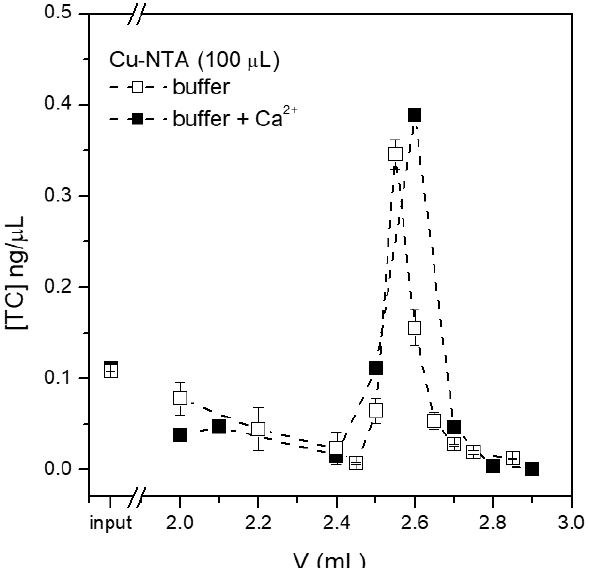
Figure 8. Effect of calcium ions on the purification of tetracycline. Chip chambers of 100 µL loaded with same amount of Cu-NTA beads were